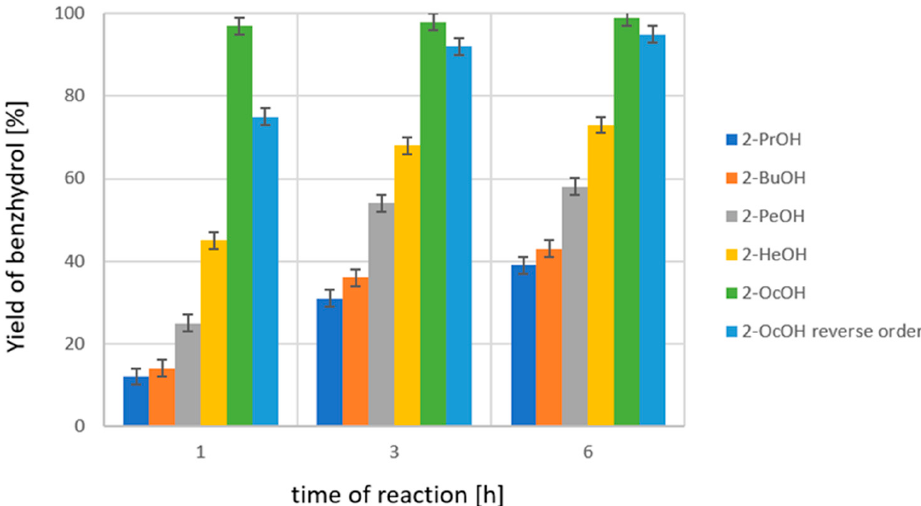
Figure 2. Liquid phase transfer hydrogenation of benzophenone with different 2-alkanols at normal pressure in the presence of MgO catalyst. Reaction conditions: W MgO = 250 ± 5 mg, 3.125 mmol of ketone, D/A = 8, selectivity >98%.